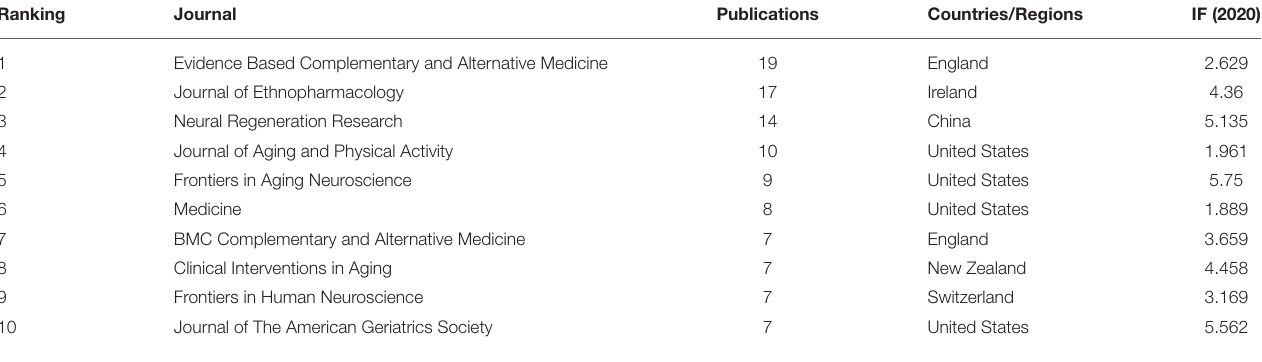
TABLE 4 | Top 10 journals in terms of publications from 2001 to 2020.